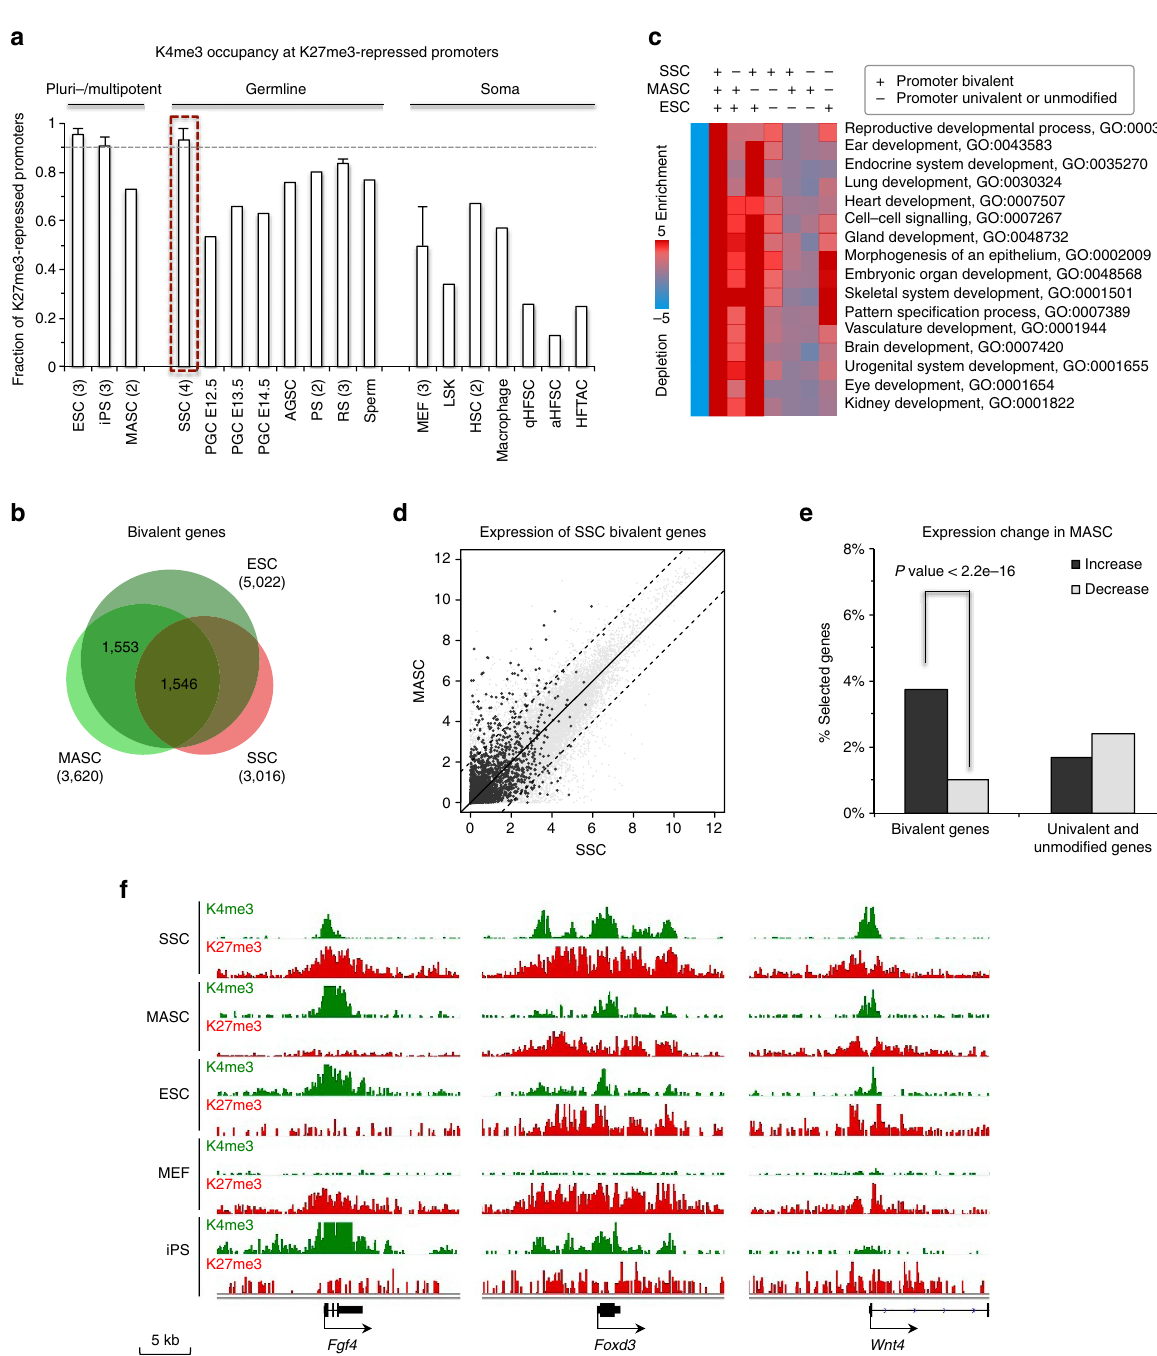
Figure 2 | ESC-like bivalent promoter modifications are largely preserved in SSCs and selectively activated in MASCs. ( a ) Fraction of K4me3 þ K27me3 bivalent promoters within K27me3-marked promoters. For each cell type with at least three biological replicates (Supplementary Data 2) from different cell lines or resources, results are presented as mean values and s.d.’s. Number in brackets, sample size. Grey dashed line, fraction ¼ 0.9. ( b ) Overlap of bivalent genes identified by peak detection in SSCs, MASCs and ESCs (see Methods). ( c ) GO enrichment in bivalent genes shared in or unique to SSCs, MASCs and ESCs. ‘ þ ’ denotes promoter bivalency detected in each cell type. Enrichment and depletion of specific GO functions (shown on the right) were measured by hypergeometric P values (log10-transformed). The first column contains genes that do not belong to any of the measured classes and is used as a control gene list. Red, over-representation; blue, under-representation. ( d ) Comparison of global gene expression profiles between SSCs and MASCs. Black dots, SSC bivalent genes identified by peak detection; dashed line, cutoff of two-fold (log2) expression difference between SSCs and MASCs. ( e ) Percentage of genes with expression increase (black) or decrease (grey) in MASCs compared to SSCs for SSC bivalent genes (3,016 genes with both K4me3 and K27me3 modifications at promoters) and SSC univalent and unmodified genes (29,565 genes modified with either K4me3, K27me3 or neither of the two modifications at promoters). P value o 2.2e-16 by Fisher’s exact test (one-sided). ( f ) Promoter modification at selected genes. Green, K4me3; red, K27me3. K4me3 track range, 0–1; K27me3 track range,